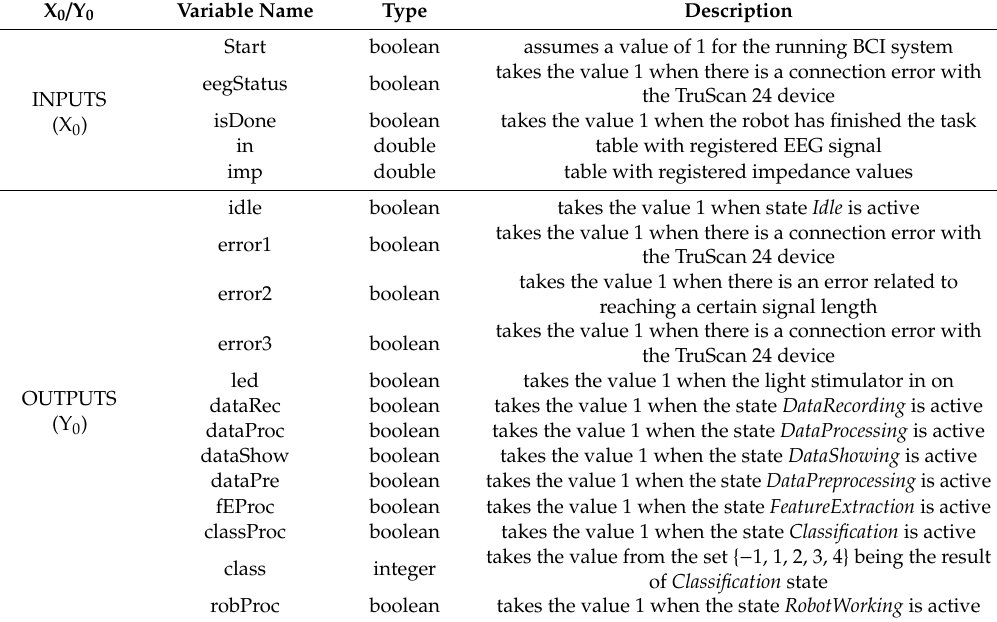
Figure 8. BCI control system developed in Matlab/Simuulink environment. Table 1. Selected input and output variables of MainController.